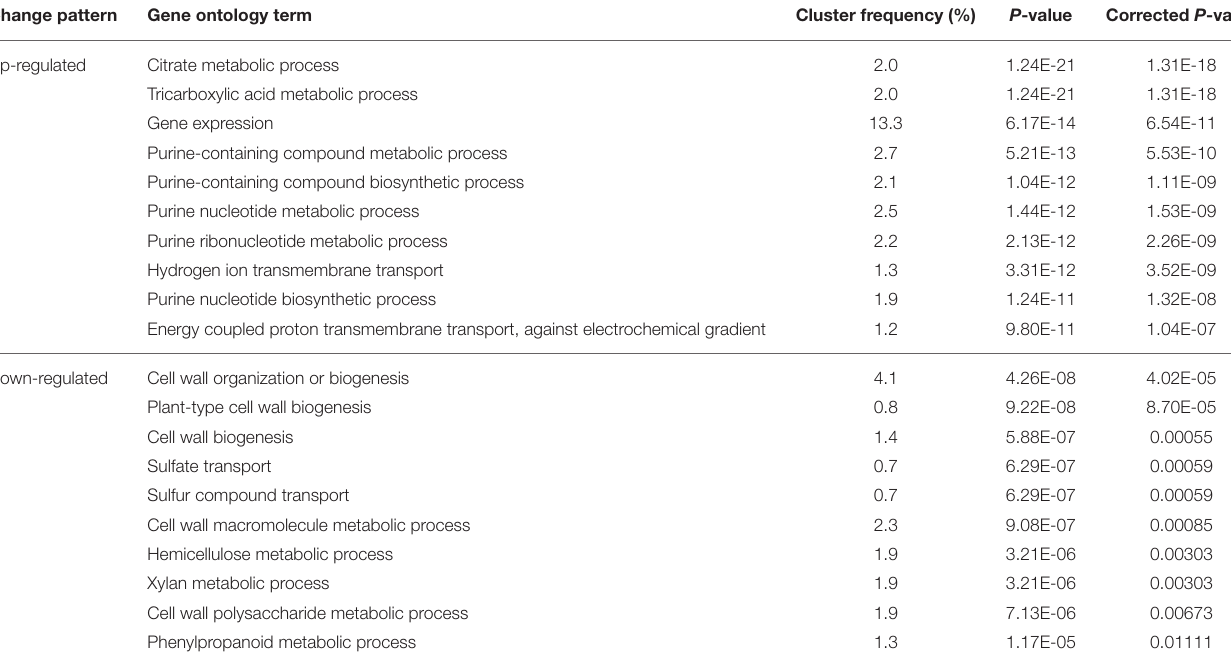
Top 10 most significant processes are